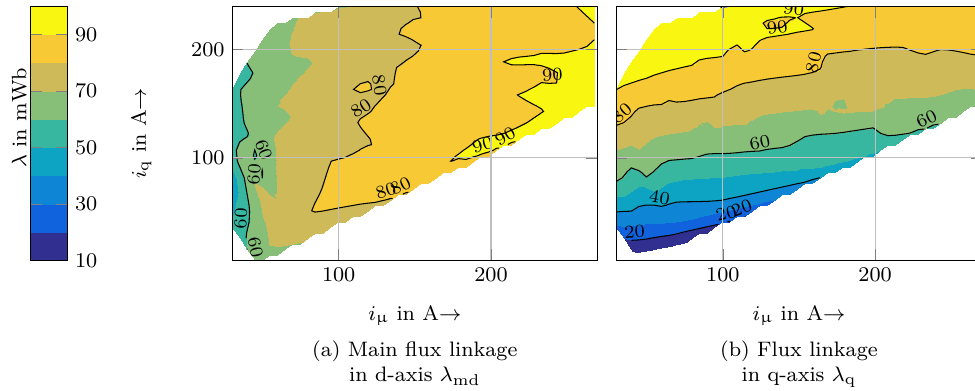
Figure 17. Measured flux linkages at 2000 rpm.